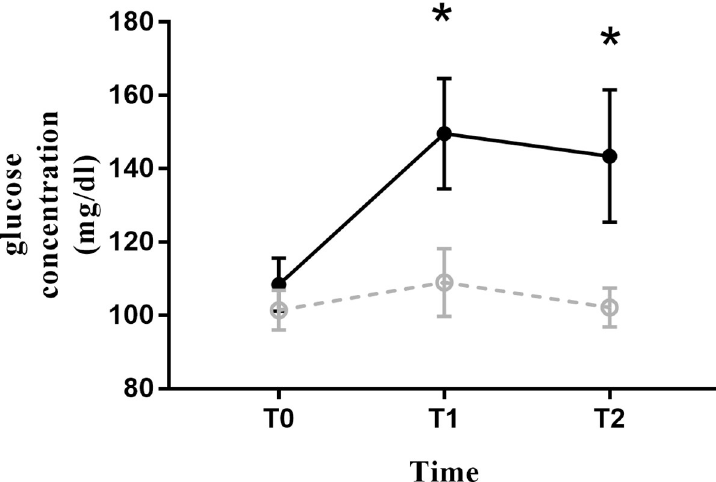
Fig 5. Plasma glucose concentration. Solid line: HYPO. Dashed line: ISO. Asterisk( � ) represents statistically significant values between the two groups.